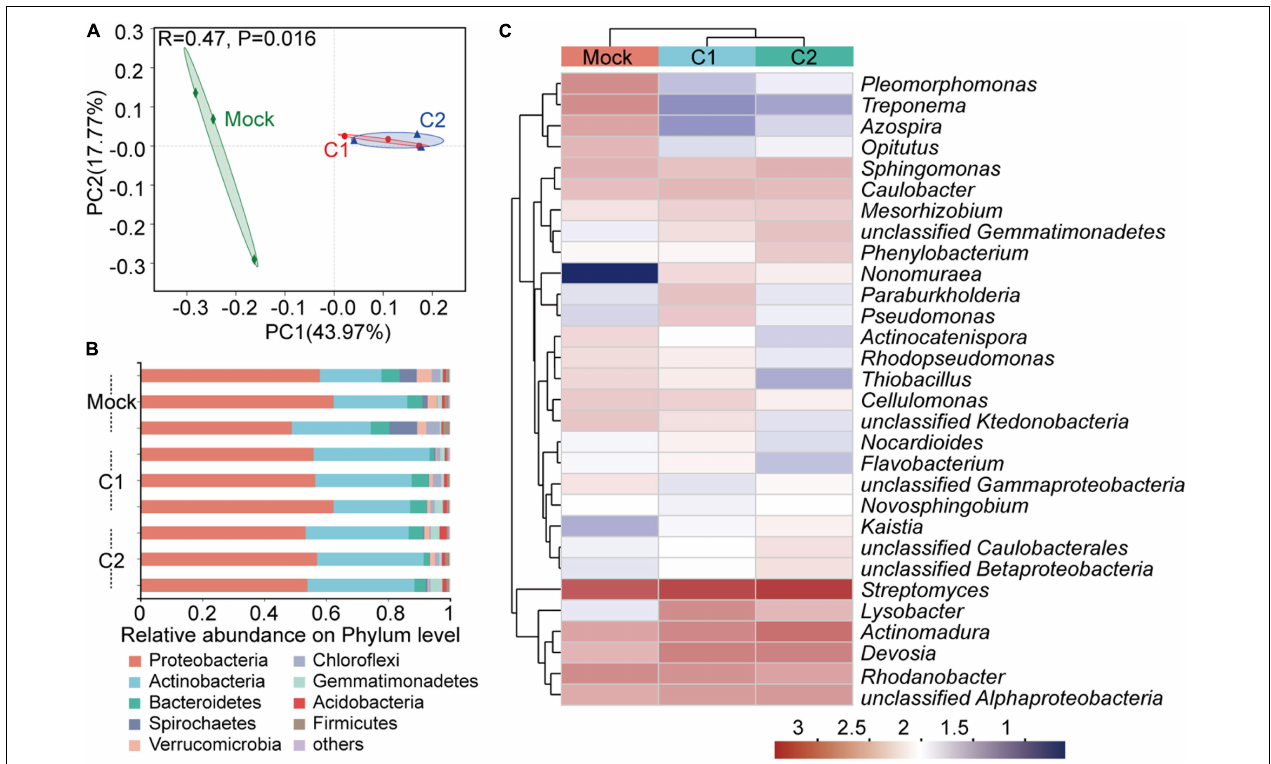
FIGURE 3 | Bacterial community of the rhizosphere 30 days after GN03 inoculation. (A) PCoA plot based on the structure of the microbial community. Mock, green diamonds; C1, red circle; and C2, blue triangles. Variation in communities was based on Bray–Curtis distances and an ANOSIM test with 999 permutations. (B) Relative abundance of bacterial phyla in different samples. (C) Heatmap showing the relative abundance of the dominant taxa with respect to treatment. Hierarchical cluster analysis was based on Bray–Curtis distances using a complete-linkage method. Each sample was measured in triplicate.